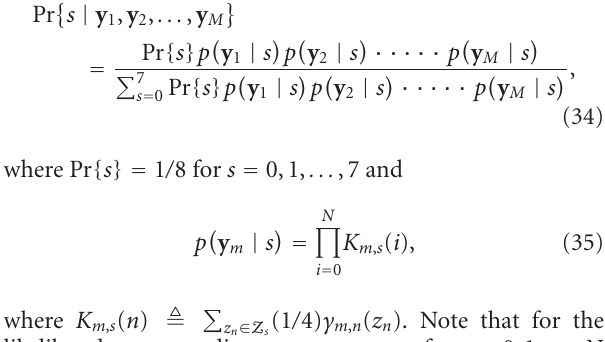
Figure 6: Bit-error performance for LLRs computed as in (25), that is, ideal LLRs, and approximated LLRs computed as in (26), for di ff erent